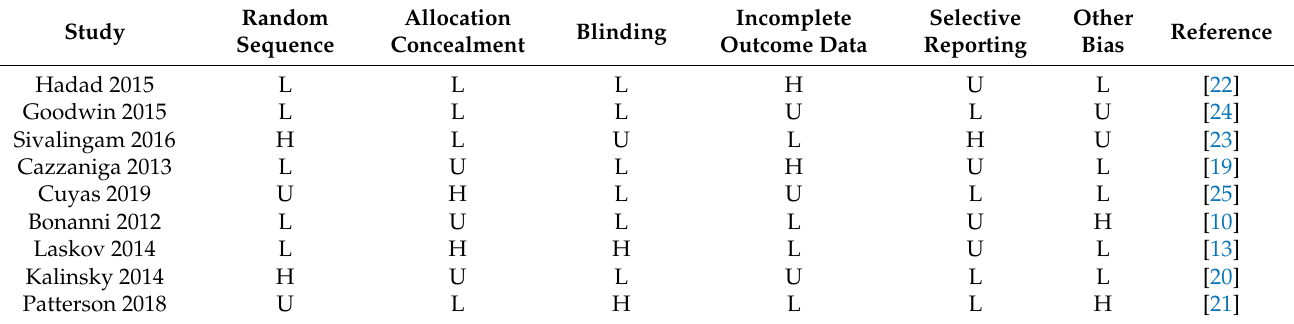
Table 2. Quality of the